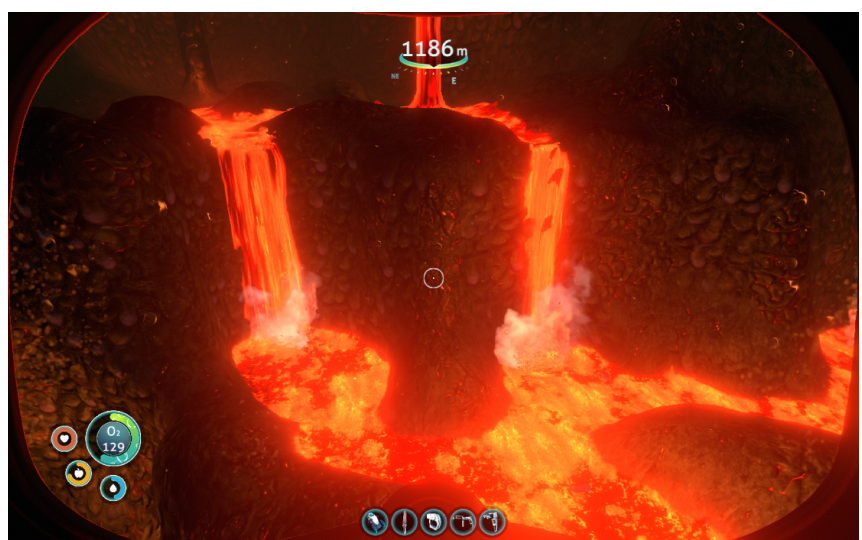
Figure 4. Underwater lava flows in Subnautica © Unknown Worlds Entertainment (2018).